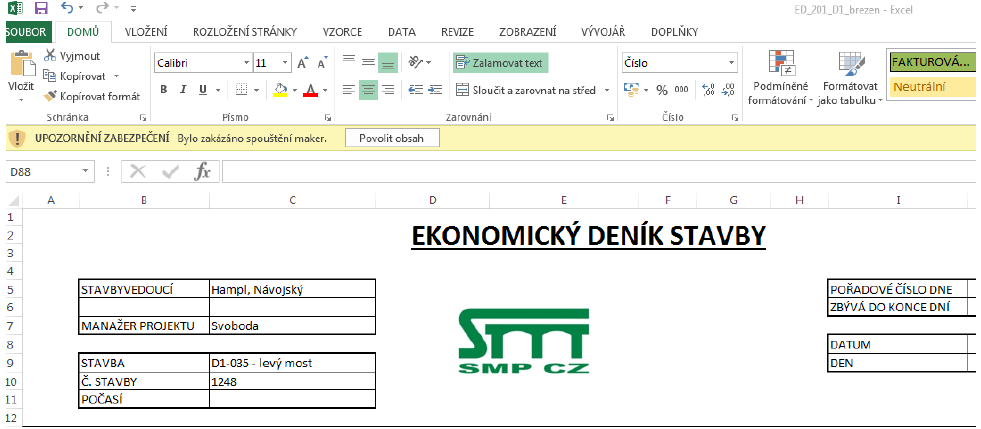
Jedná se o software pro zaznamenávání denních záznamů. Ve formě Excelu s makry nebo webovém